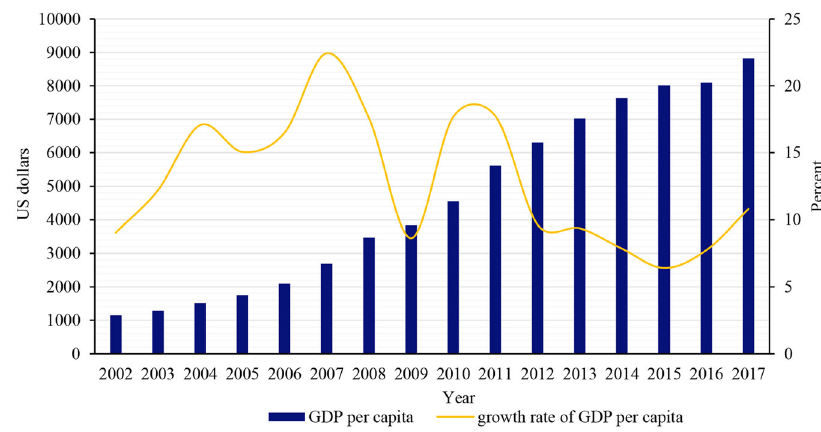
Fig. 2 China ’ s GDP per capita and its growth rate from 2002 to 2017.